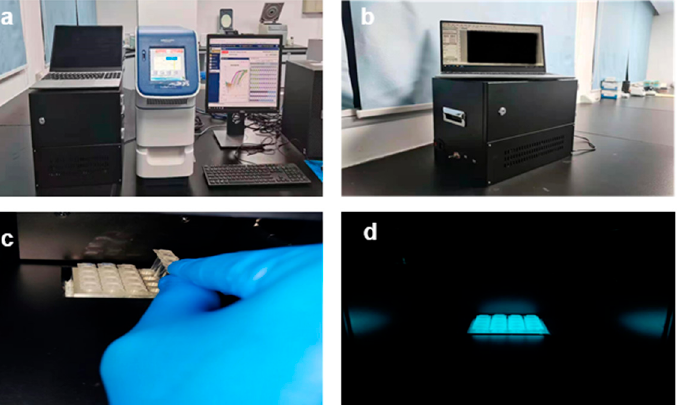
Figure 2. Comparison photos with ( a ) the ABI-STEPONE system and ( b ) the HDLRT-qPCR system. ( c ) The sample is placed on the heating block inside the HDLRT-qPCR system; ( d ) the light is turned on to excite fluorescence.